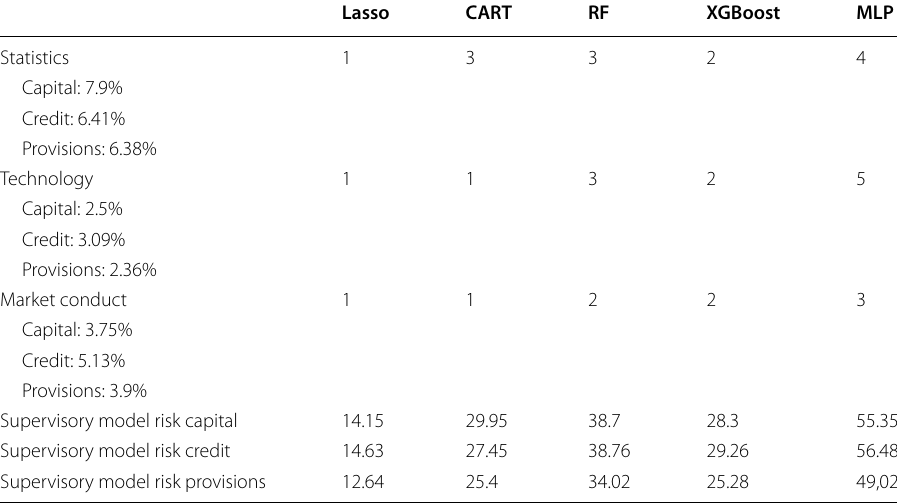
Table 6 Scorecard phase 2: computing the supervisory riskiness for regulatory capital Lasso